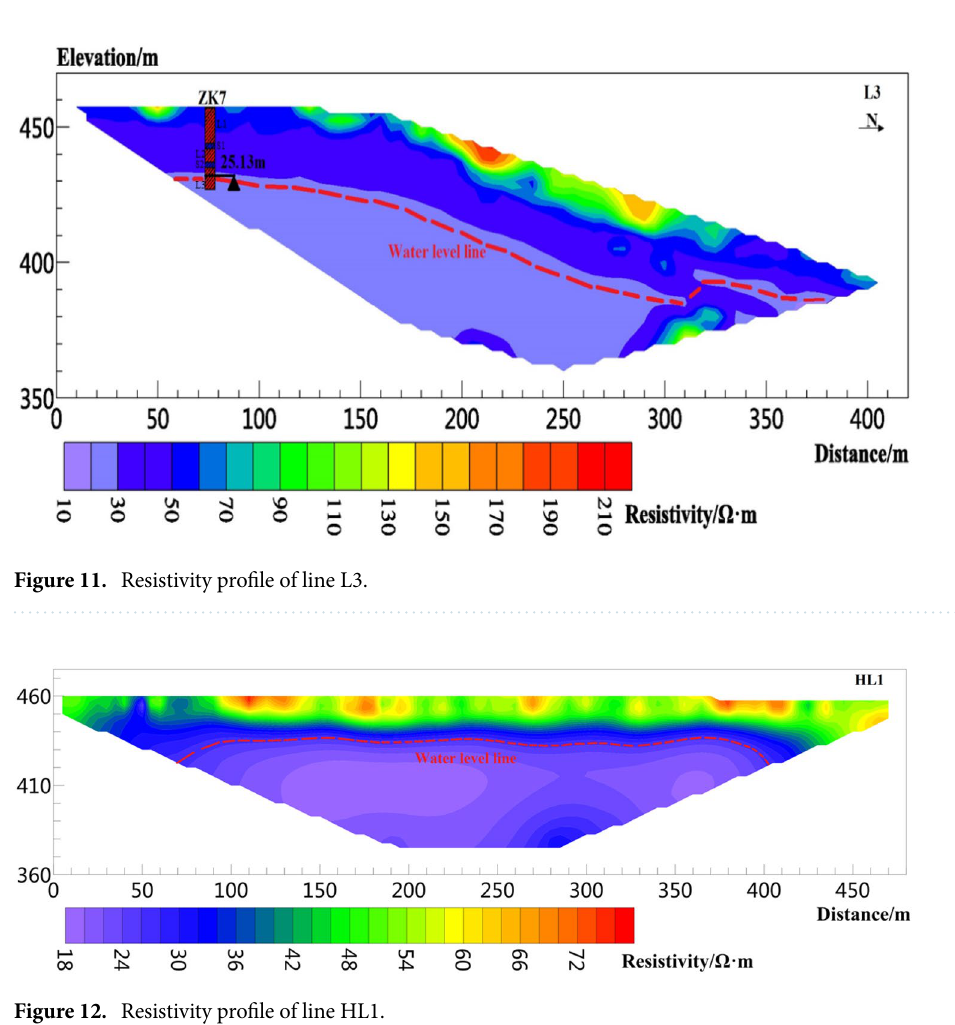
Figure 12. Resistivity profile of line HL1.